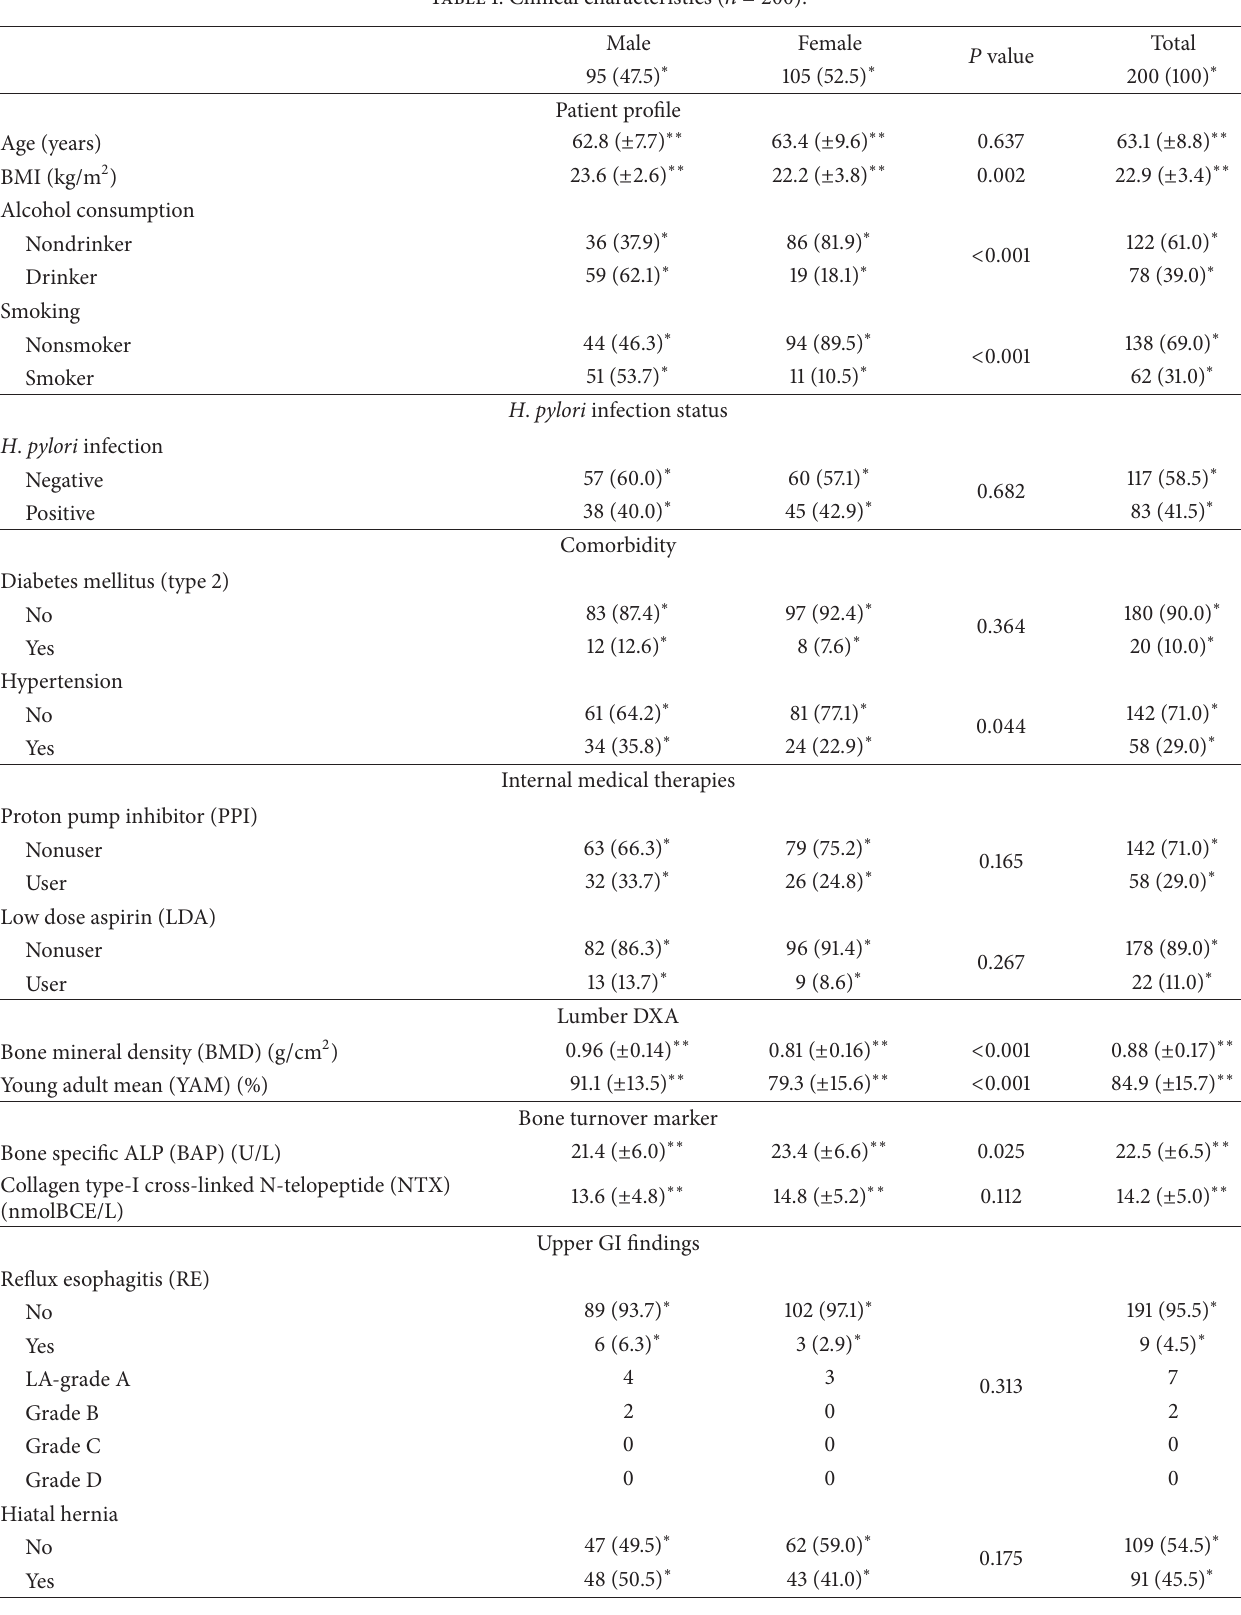
Table 1: Clinical characteristics (𝑛 = 200)